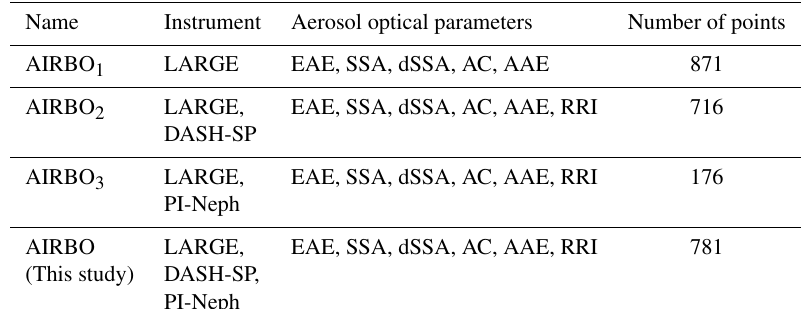
Table A1. Definition of three datasets (AIRBO 1 , AIRBO 2 , AIRBO 3 ) and their combination, AIRBO (which is the dataset used in this study); the airborne instruments involved during SEAC 4 RS (see Table 1); the co-located parameters (see Table 2 for a definition of EAE, SSA, dSSA, AC, AAE and RRI); and the number of data points showing valid aerosol optical properties and PS-AMT BBAg., BBWild., Bio. or PollDust.